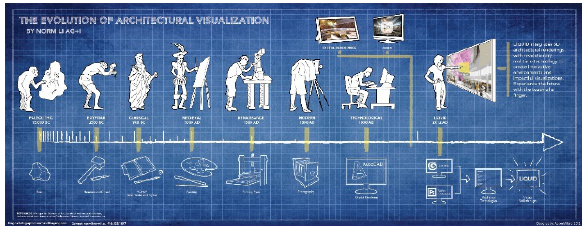
Figure 1. The evolution of the architectural visualization (Metropolitan Museum of Art. Millard, A., 2012)